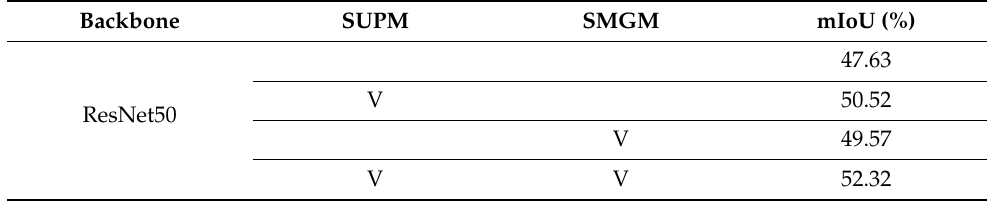
Table 2. Testing with SUPM AND SMGM on PASCAL VOC2012 Training Dataset of Pseudo Masks in MIOU